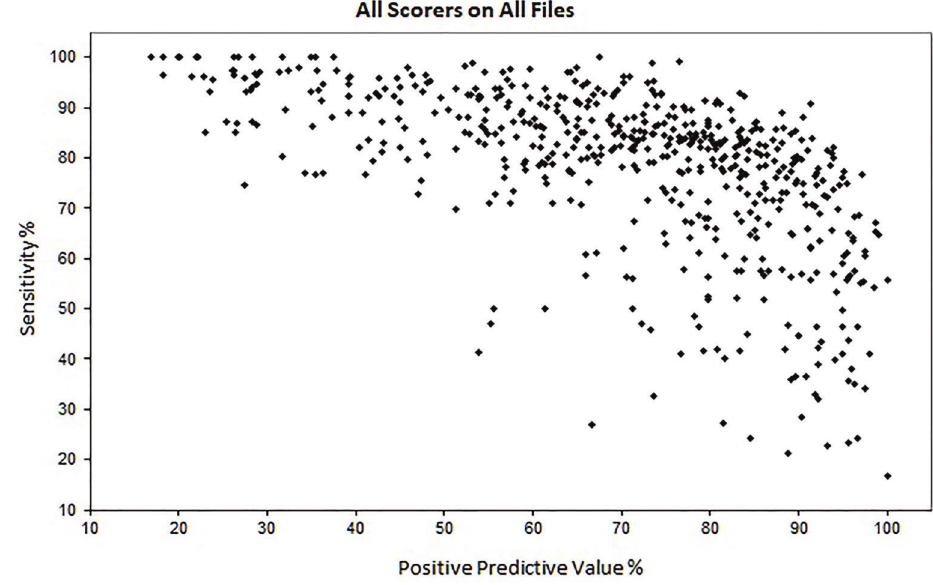
Figure 5. Sensitivity scatter plot versus positive predictive value for all pairwise fi le-by- fi le